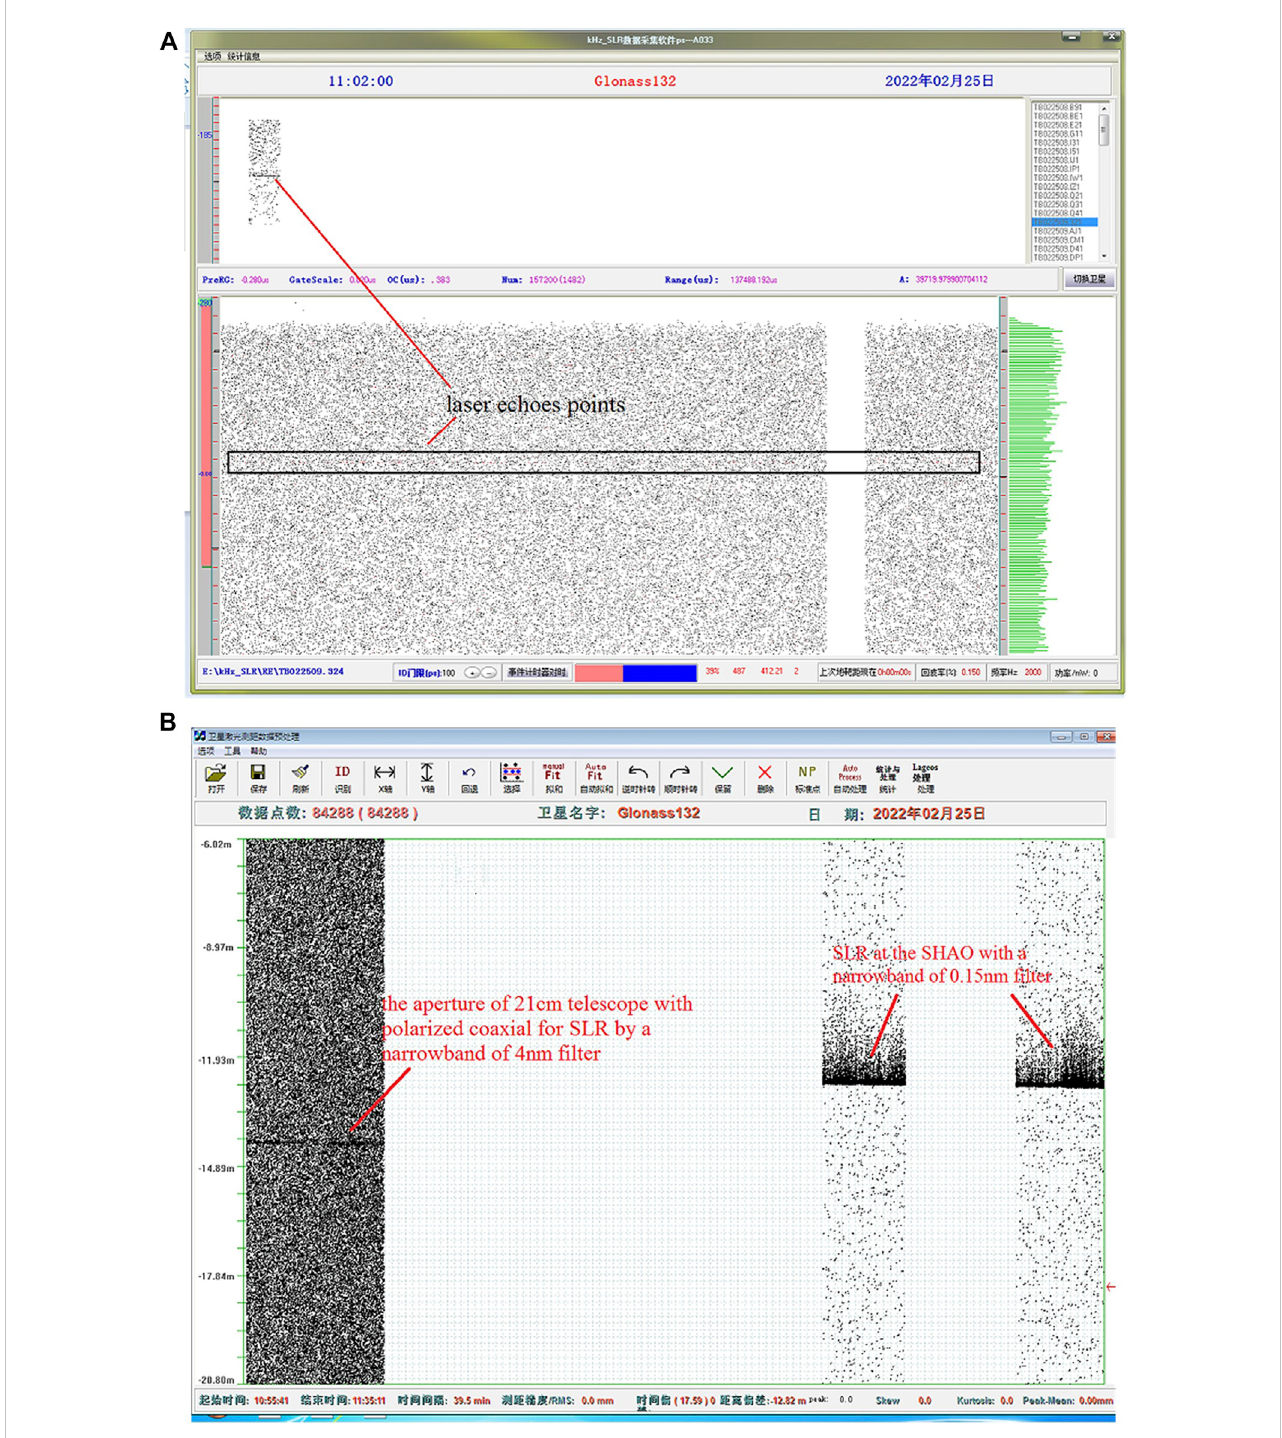
FIGURE 3 Real-time measurement (A) and data processing of the Glonass